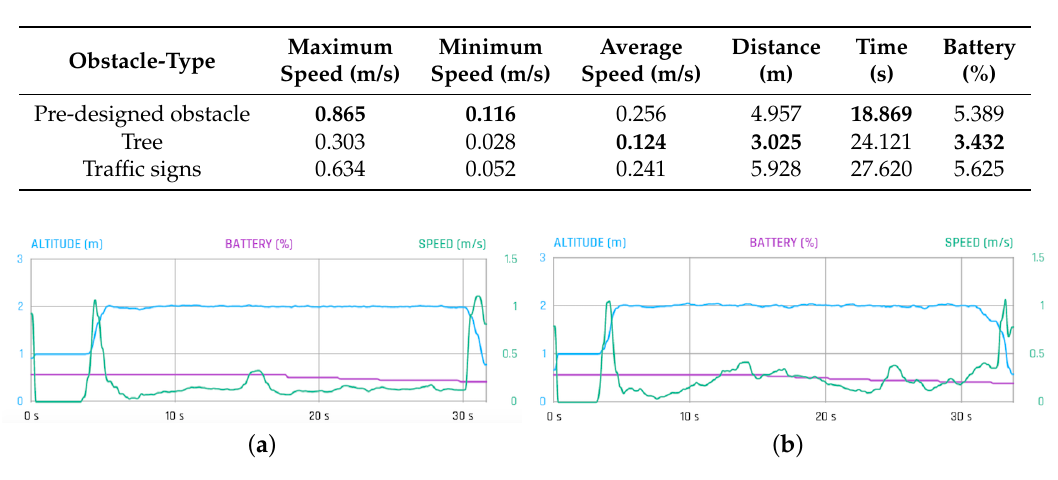
Table 6. Tree and traffic sign obstacles.